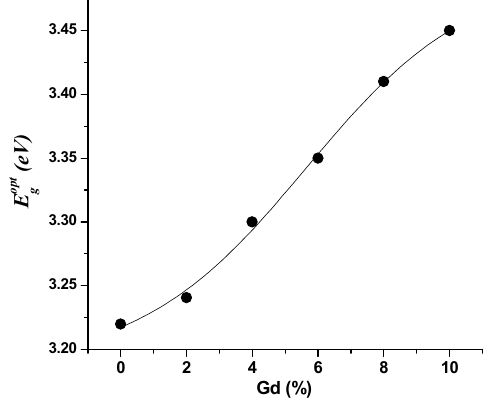
Figure 10. Plot of the optical energy gap versus the Gd content.